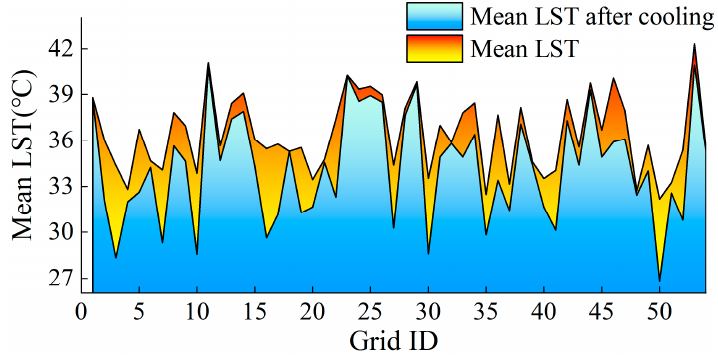
Figure 8. Comparison of average LST in the grid before and after ecological land deployment. The cooling range is between 0.04 °C and 6.02 °C, and the average temperature drop is 2.16 °C.